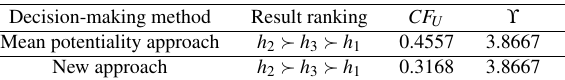
Table 12: The comparison results of the substantial uncertainty factors of overall uncertainty Decision-making method